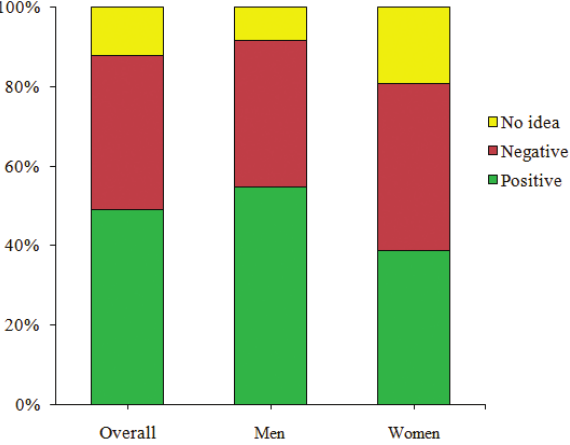
Figure 3. Cumulative and gender-wise responses to A4: “What is your attitude towards nuclear power?”.